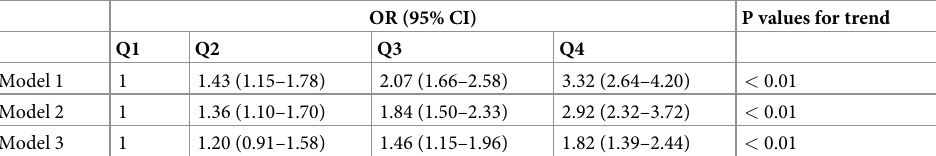
Table 5. Association of serum uric acid quartiles with